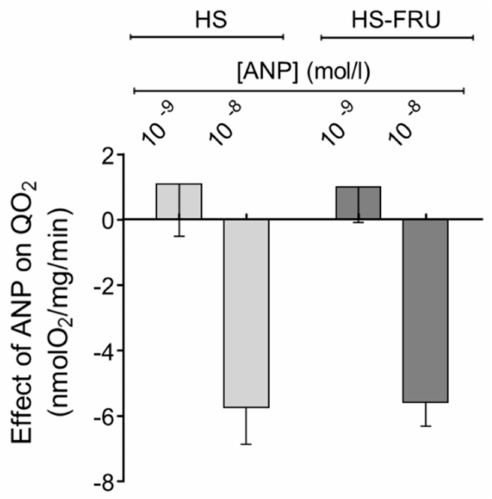
Figure 5. Effect of atrial natriuretic peptide (ANP) on oxygen consumption (QO 2 ) by proximal tubule suspensions from rats fed a high-salt diet drinking tap water (HS) or 20% fructose (HS-FRU). By two-way ANOVA: ANP effect ( p < 0.005); fructose effect ( p = 0.99); interaction ( p = 0.91).